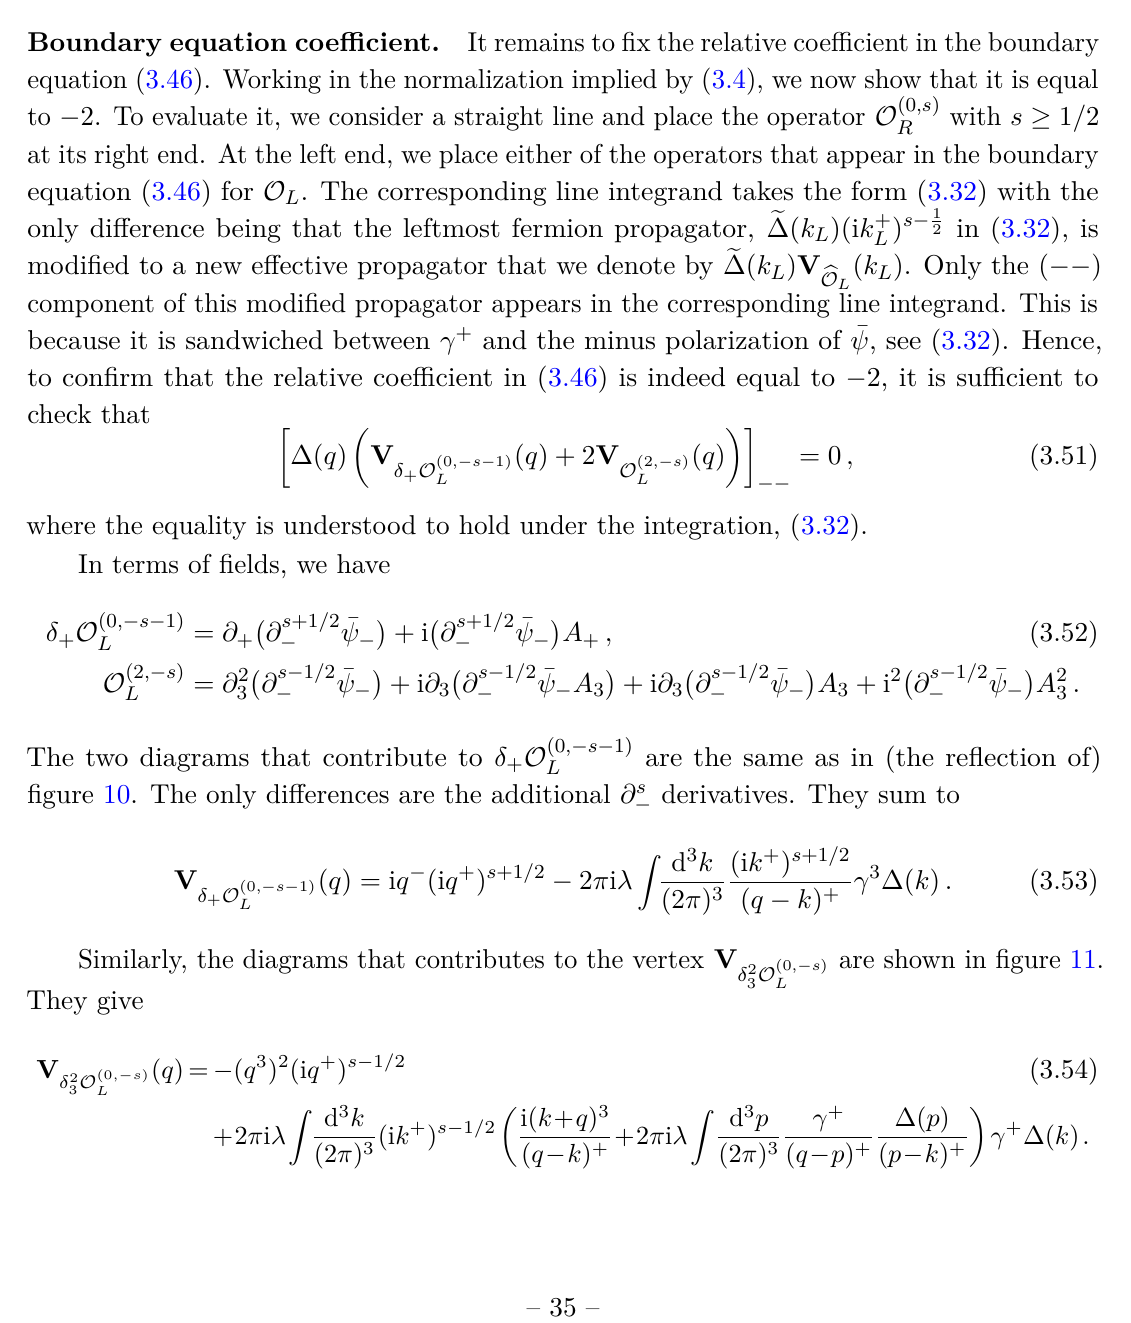
O (0 , − s ) WO (0 ,s ) i 3 L R